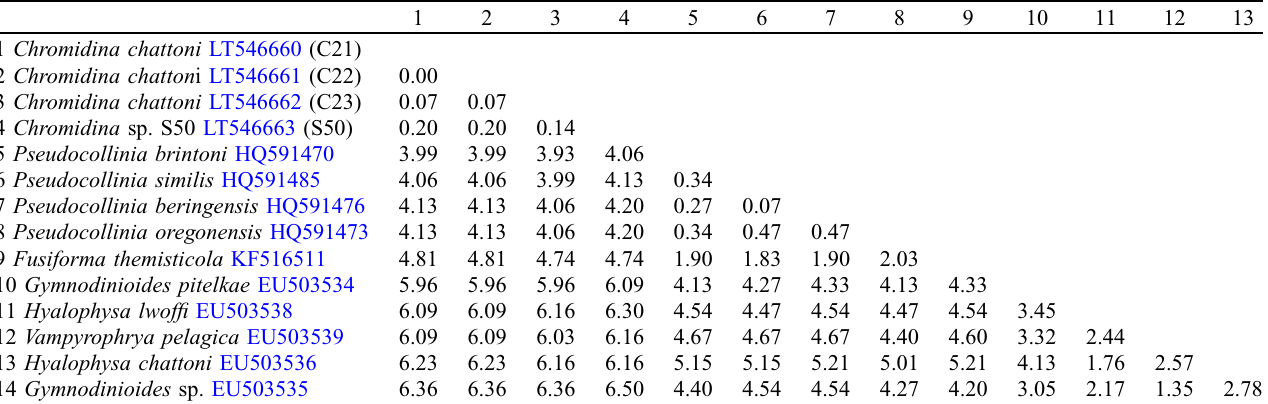
Table 2. Genetic distances (%) between sequences of representative Apostomatia.